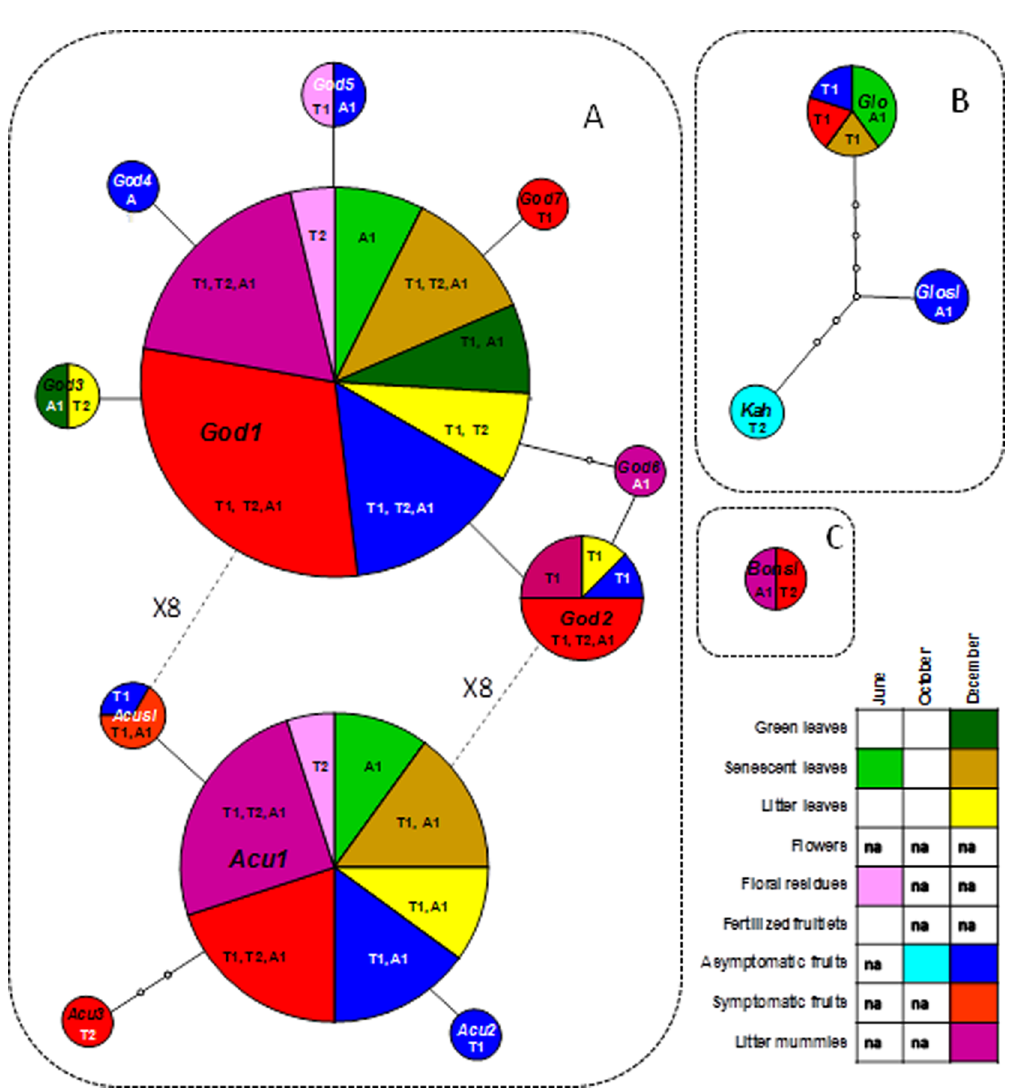
Fig. 2. Genotype networks based on ITS sequences of Colletotrichum acutatum sensu lato (A), C. gloeosporioides s.l. (B) and C. boninense s.l. (C), detected in different olive tissues in 3 different phenological phases (June, October and December). According to the caption (bottom right of the figure) different colors were used to connect detected genotypes and analyzed olive samples. Empty white boxes in the caption indicate analyzed samples that did not produce any positive amplification, while white boxes containing ‘‘na’’ indicate non-analyzed samples. The letters ‘‘T1", "T2" and "A1’’ inside the circles were used to indicate sampling fields where genotypes were detected (Cfr. Table 2). The size of each circle represents the relative frequency of genotypes in terms of number of samples in which they were detected. Genotypes were identified according to their phylogenetic collocation (Cfr. Fig. 1) and named using the initials of the corresponding species as follows: C. godetiae (Glo), C. acutatum s.s. (Acu), C. gloeosporioides s.s. (Glo), C. kahawae (Kah), C. acutatum s.l. (Acusl), C. gloesporioides s.l. (Glosl) and C. boninense s.l.